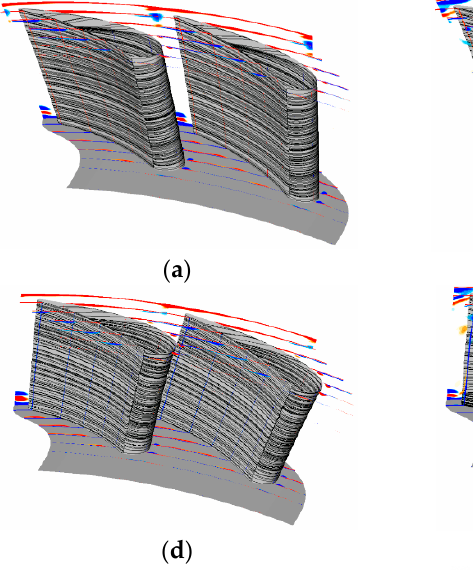
Figure 20. Comparison of vortex structure due to the swirl clocking − SL0 SP0 model (Baseline): ( a ) No swirl (front view); ( b ) SW@LE (front view); ( c ) SW@PC (front view); ( d ) No swirl (rear view); ( e ) SW@LE (rear view); ( f ) SW@PC (rear view).